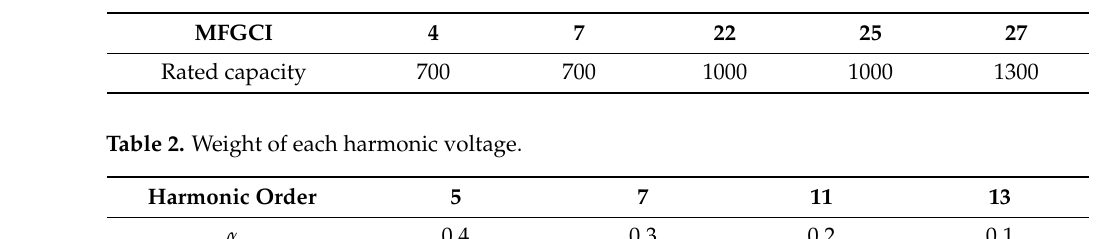
Table 1. Rated capacity of MFGCI (kW).